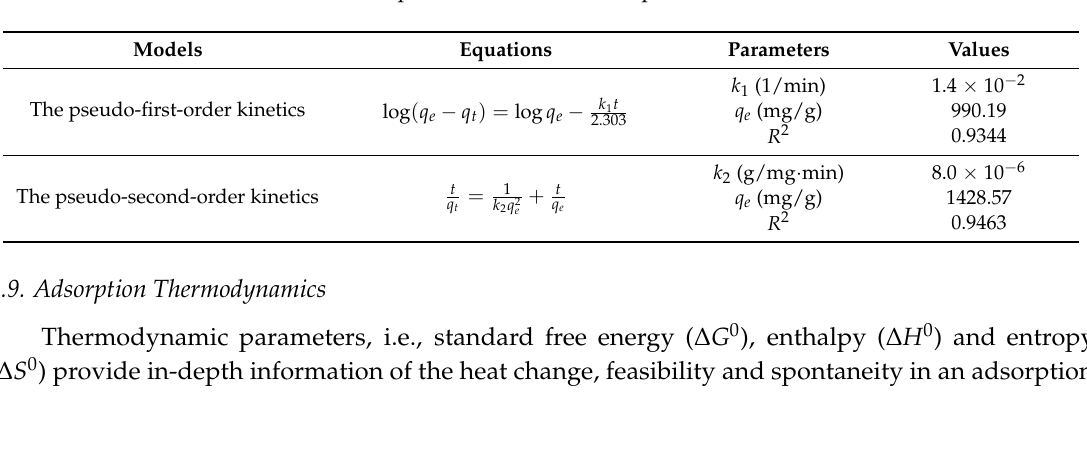
Figure 18. The kinetics for adsorption of MG onto nZVZ (initial pH = 5, temperature = 25 ◦ C, initial concentration = 700.00 mg/L). Table 9. The kinetic parameters for the adsorption of MG onto